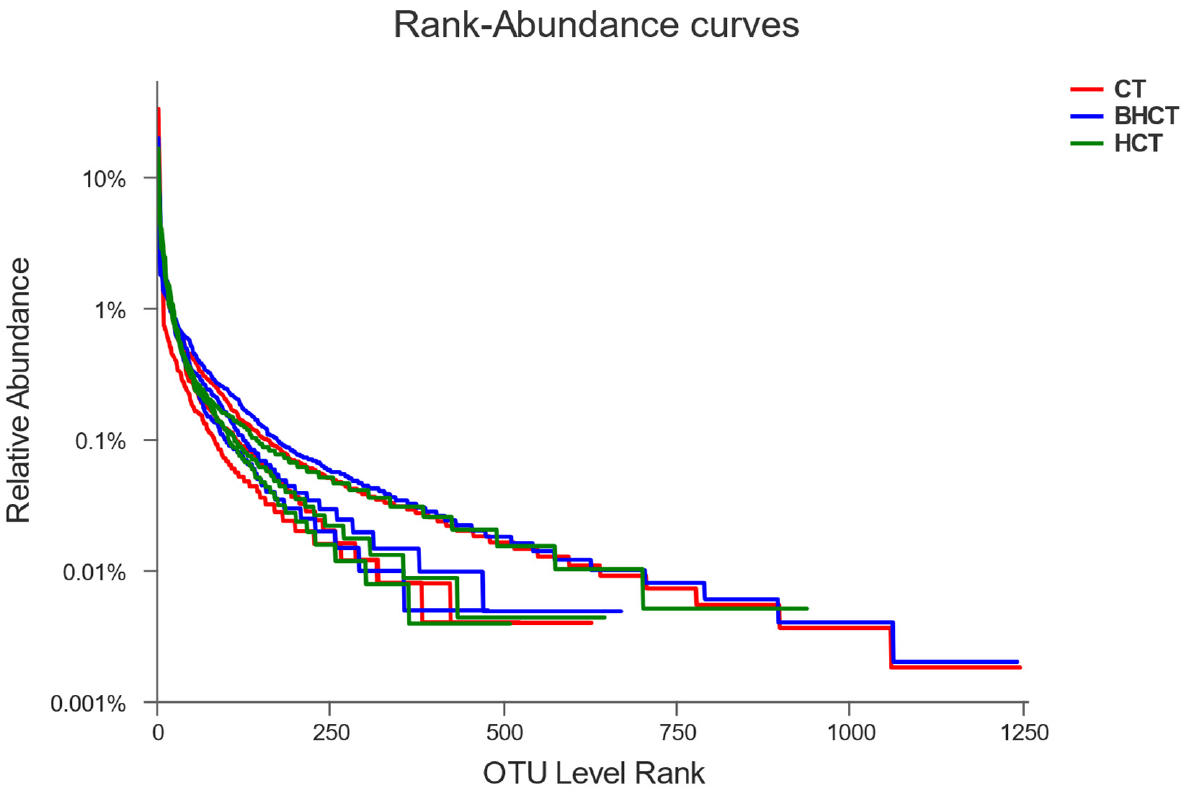
Figure 1. Rank-abundance distribution curve at the OTU level.